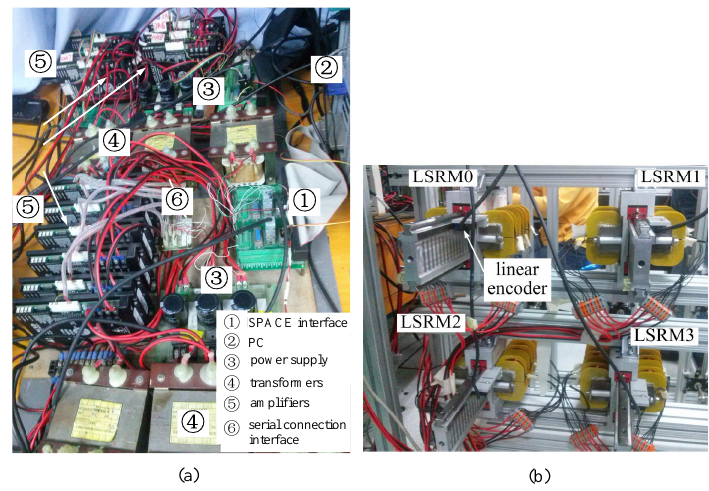
Figure 6. experimental setup: ( a ) power supplies, drivers, controllers and ( b ) the LSRMs.